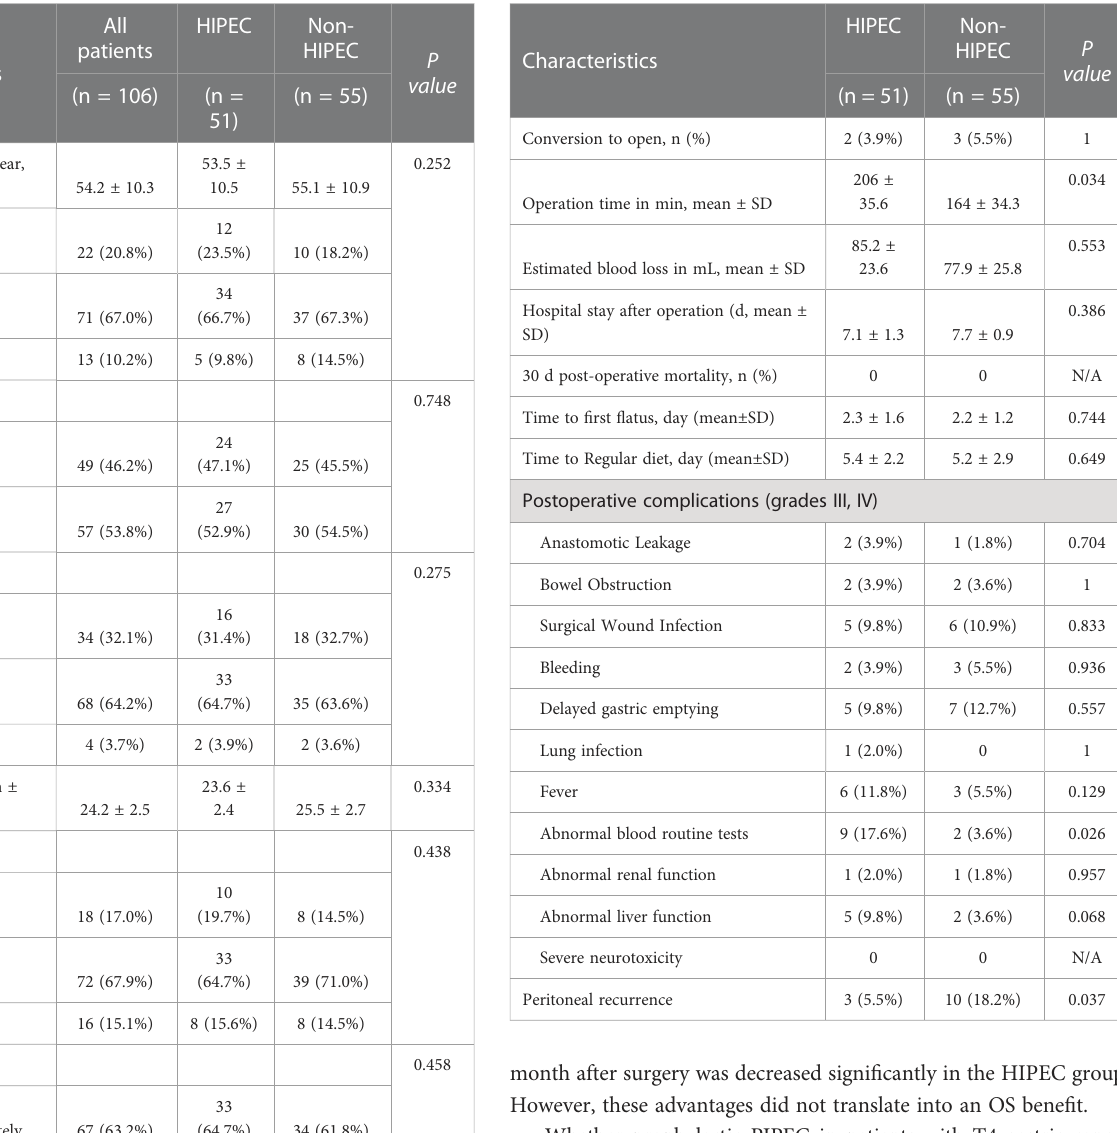
TABLE 1 Baseline characteristics of the T4 gastric cancer patients.